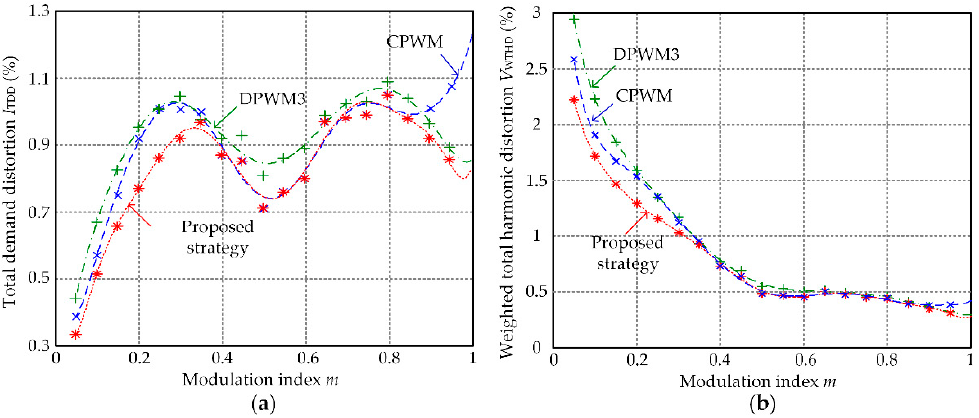
Figure 11. Variations of I TDD and V WTHD with the change of m for CPWM, DPWM3, and the proposed strategy: ( a ) I TDD ; ( b ) V WTHD . strategy: ( a ) I TDD ; ( b ) V WTHD .